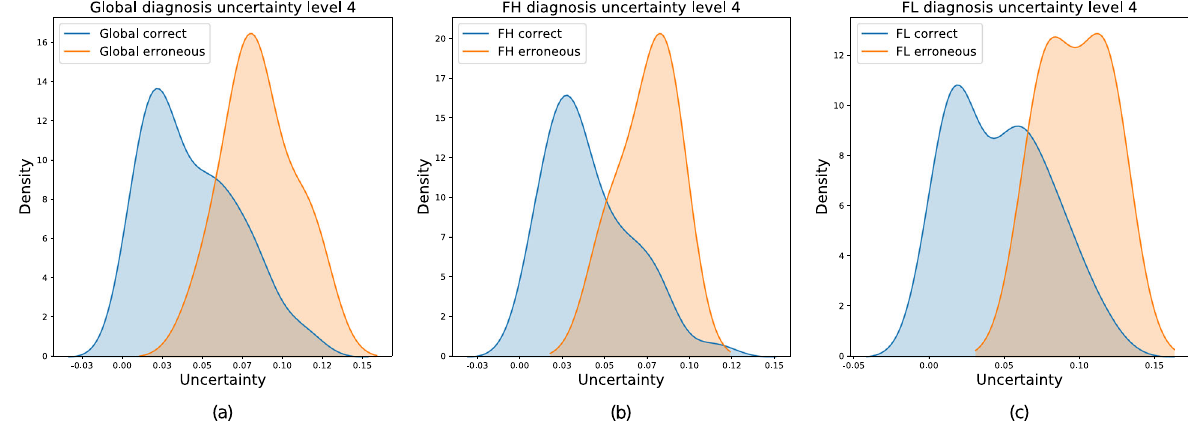
Fig. 4 Erroneous predictions always correlate with higher uncertainty values. Uncertainty densities for any class patch prediction (FL or FH, i.e. global diagnosis) ( a ), FH prediction only ( b ), and FL prediction only ( c ). In each case, correct (blue) and erroneous (orange) diagnosis distributions are